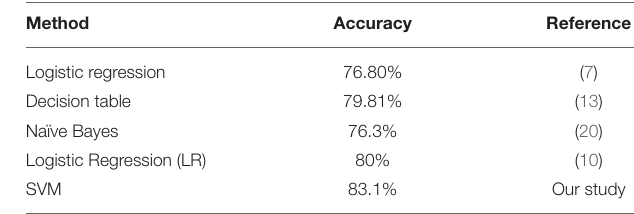
TABLE 5 | Comparison of the proposed work with the existing works (Pima